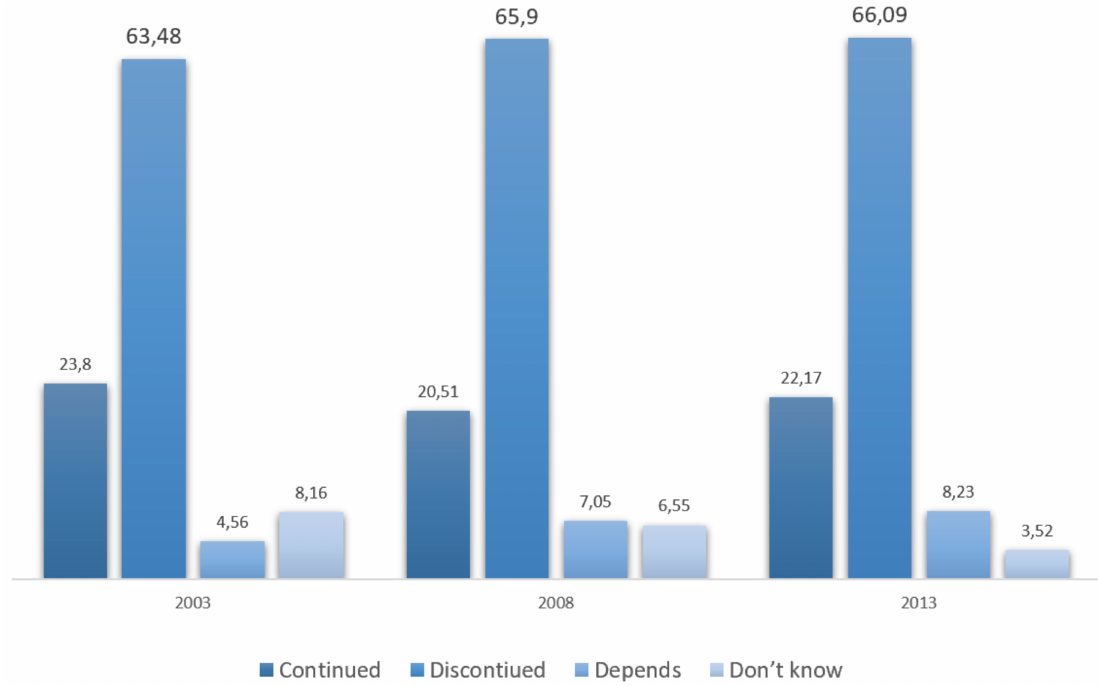
Figure 5. Respondents’ perception regarding discontinuation of